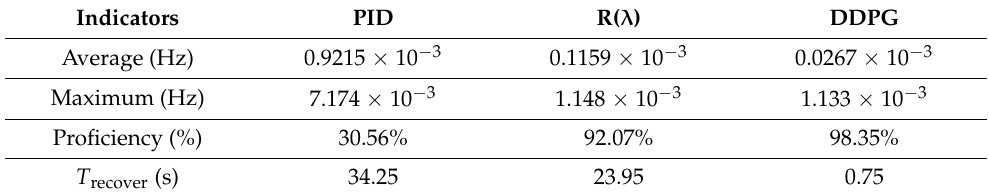
Table 4. Frequency simulation results under wind disturbance.